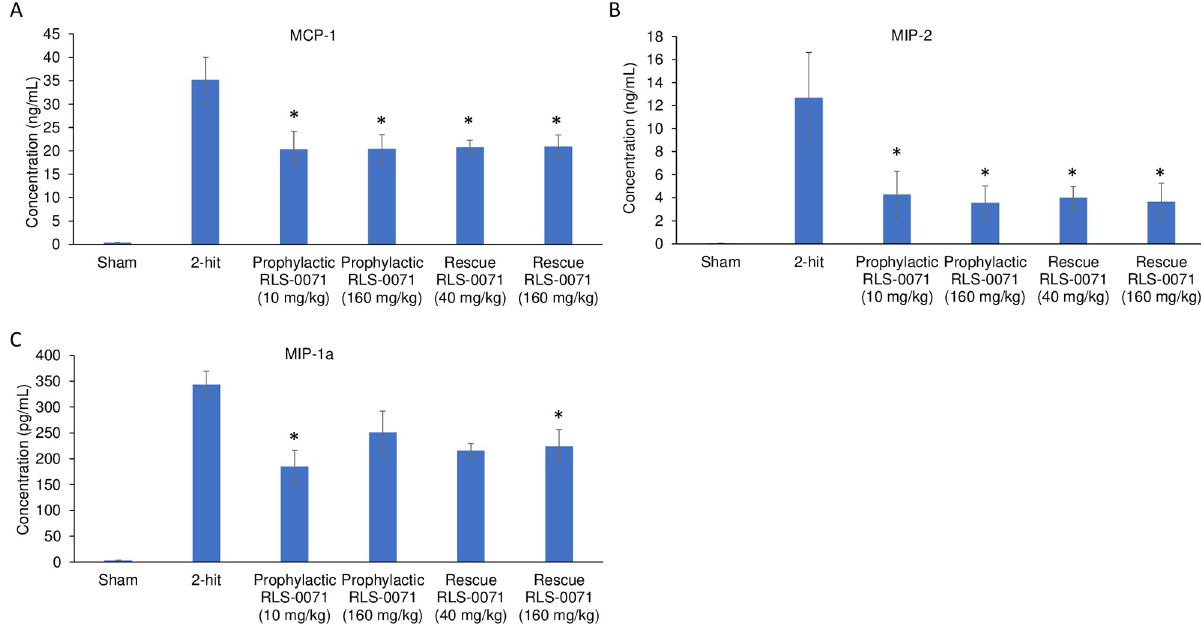
Fig 7. RLS-0071 reduces levels of inflammatory chemokines in the blood. Chemokine levels (A) MCP-1, (B) MIP-1a and (C) MIP-2 from terminal blood draws were determined by xMAP bead based immunoassay for the following experimental groups: sham, 2-hit, 2-hit + 10mg/kg prophylactic dose RLS-0071, 2-hit + 160mg/kg prophylactic dose RLS-0071 as well as 2-hit + 40mg/kg rescue dose RLS-0071 and 2-hit + 160mg/kg rescue dose RLS- 0071. For sake of clarity only rescue dosing data is shown. Data are means and standard error of the mean. � denotes P < 0.05 compared to animals receiving the 2 hit insult.